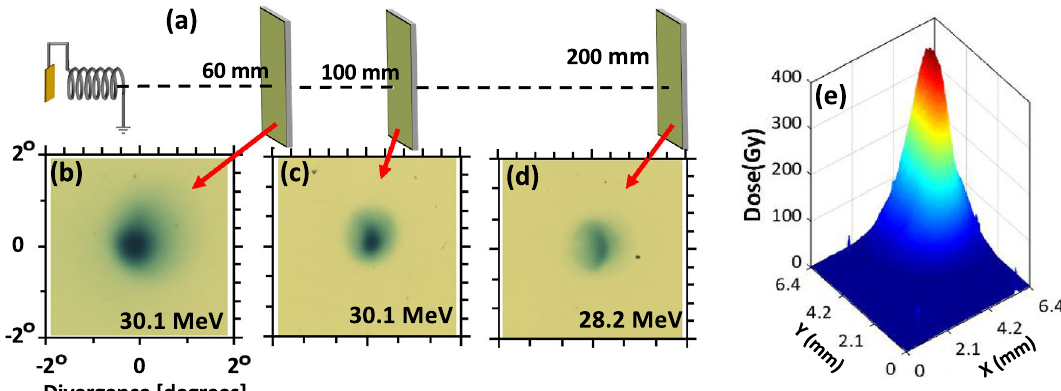
Figure 3. (a) Experimental setup (not to scale) used for characterizing the degree of beam collimation achieved by HC targets. Irradiating identical HC targets at similar laser conditions, proton beams were diagnosed by placing the RCF stack at different distances from the interaction foil. The HC targets used in this case were made of 0.125 mm thick Stainless steel wire of internal diameter, pitch and length of 0.7 ± 0.015 mm , 0.35 ± 0.015 mm and 10 ± 0.1mm respectively , designed to synchronise optimally with ∼ 9 MeV protons and post-accelerate them to ∼ 30 MeV. (b–d) show spatial profiles of ∼ 30 MeV proton beams captured by the RCF stack placed at 60 ± 1mm , 100 ± 1mm and 200 ± 1mm respectively. (e) shows the 3D dose profile of the proton beam shown in